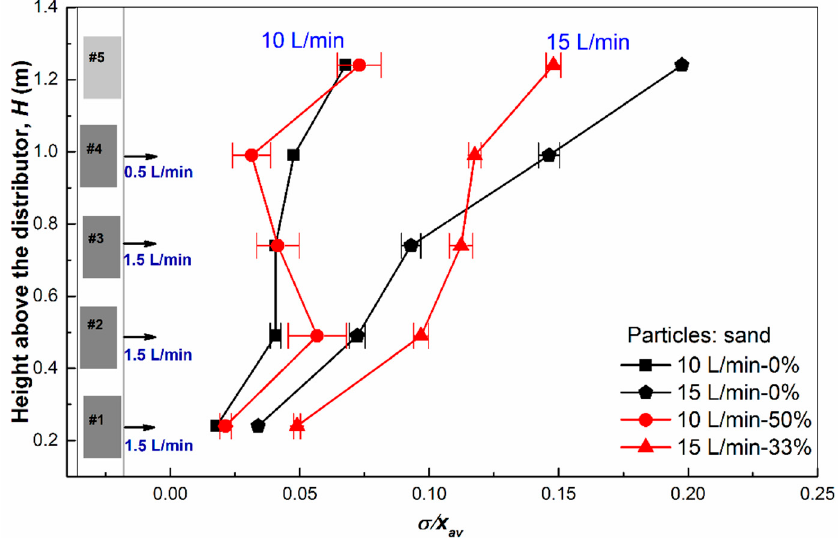
Figure 12. Effects of gas extraction through porous membranes on the σ r of the differential pressure signals. The other operation conditions were: T = 550 °C, P = 0.1 MPa, H ini = 1.28 m, U = 0.09 – 0.14 m/s, silica sand.